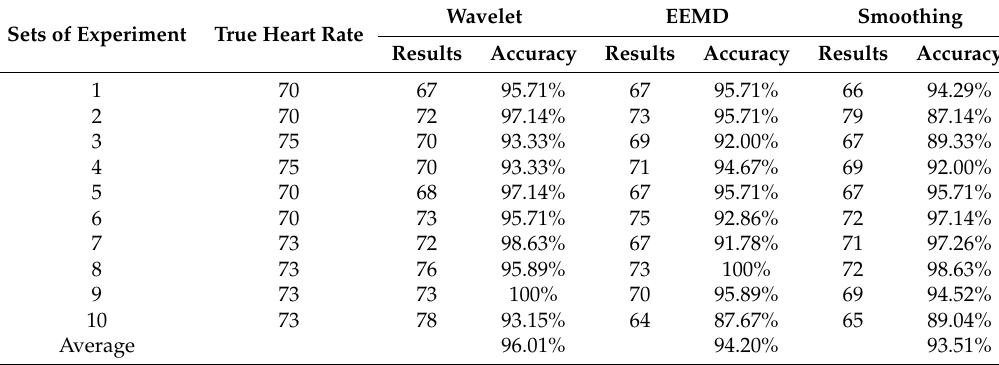
Table 5. The results of the heart-rate test with the time period of 30 s.